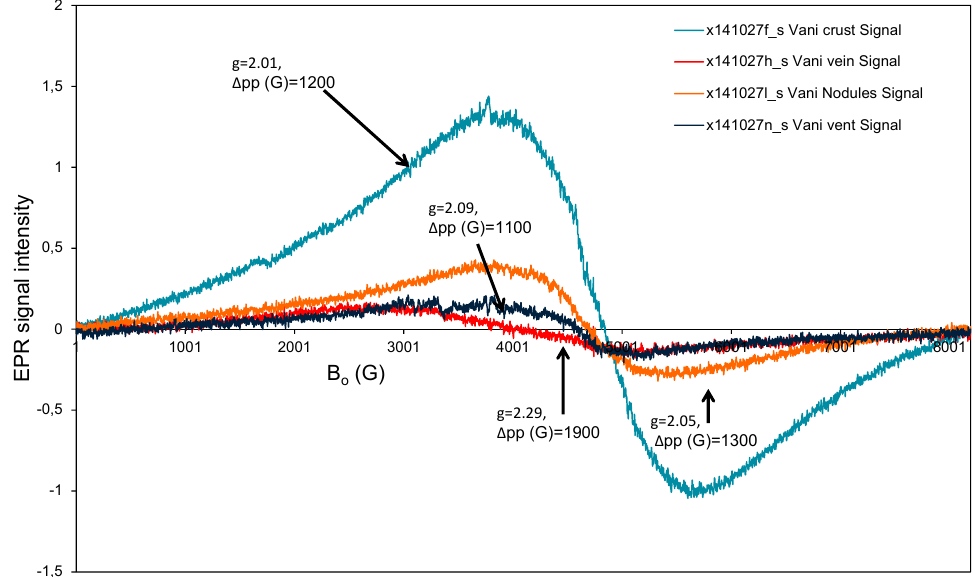
Figure 5. Electron paramagnetic resonance (EPR) spectra for Cape Vani Mn oxide samples, i.e., crusts and Mn mats (Vani crust), chimneys (Vani vent), Mn-nodules (Vani Nodules), and feeder veins (Vani vein). Also shown are g values and ∆ pp (G) for each sample type. (G is the unit gauss; g is the (electronic) g factor (dimensionless)).